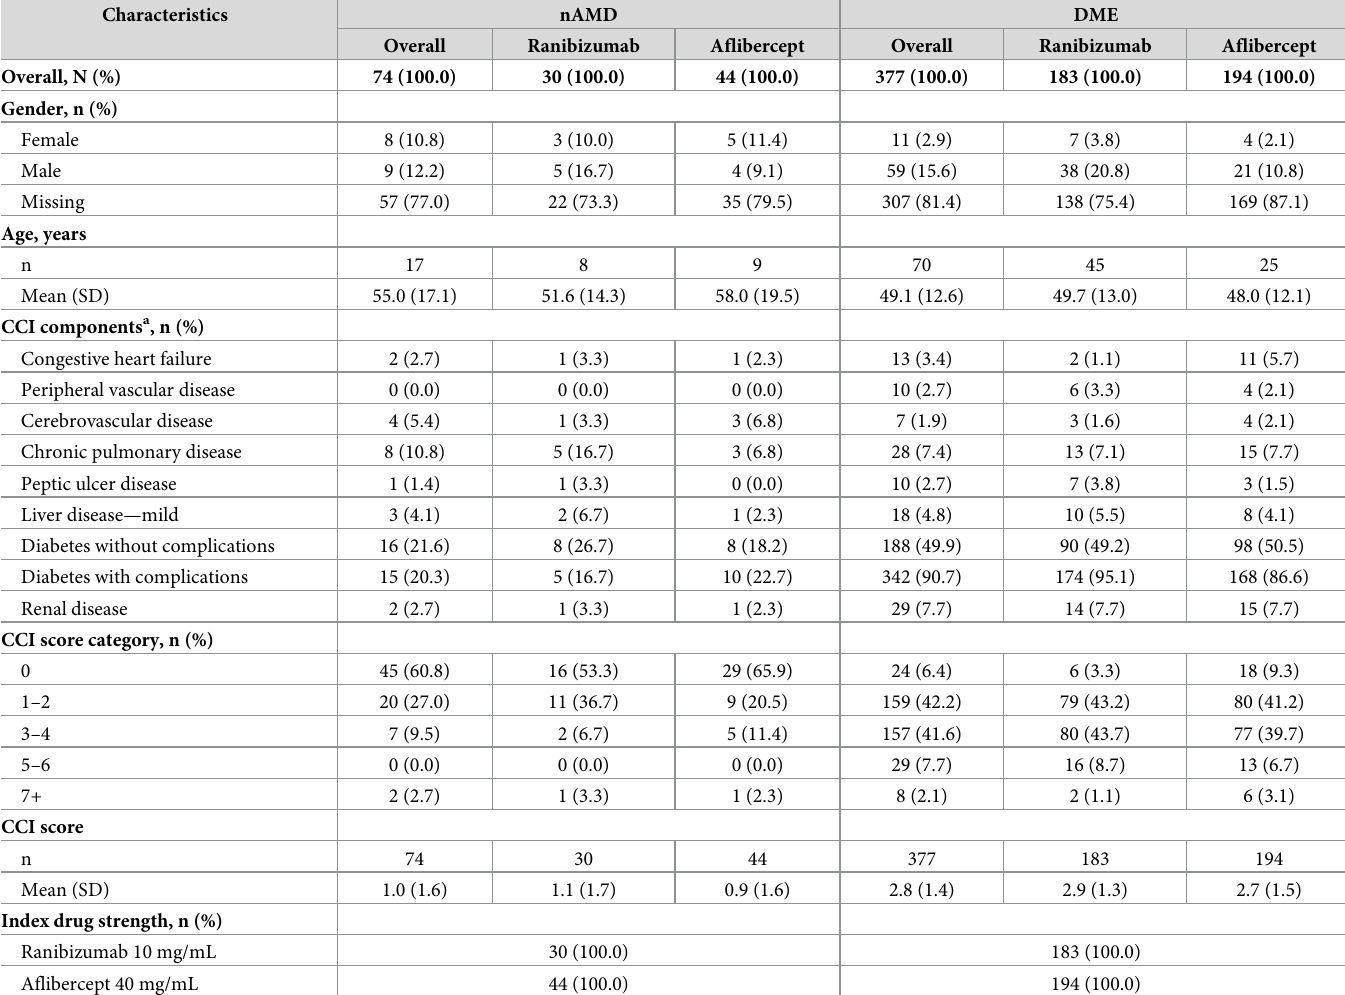
Table 1. Baseline demographic and clinical characteristics of the study patient